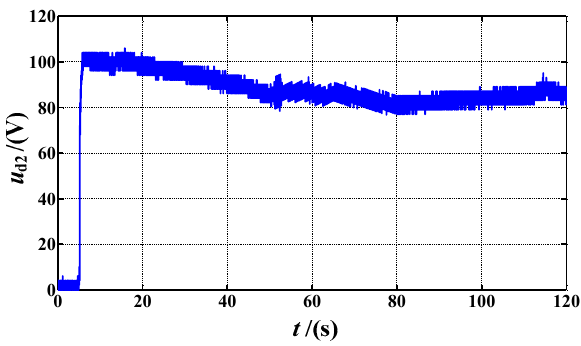
Figure 15. DC Voltage of rectifier at secondary side.